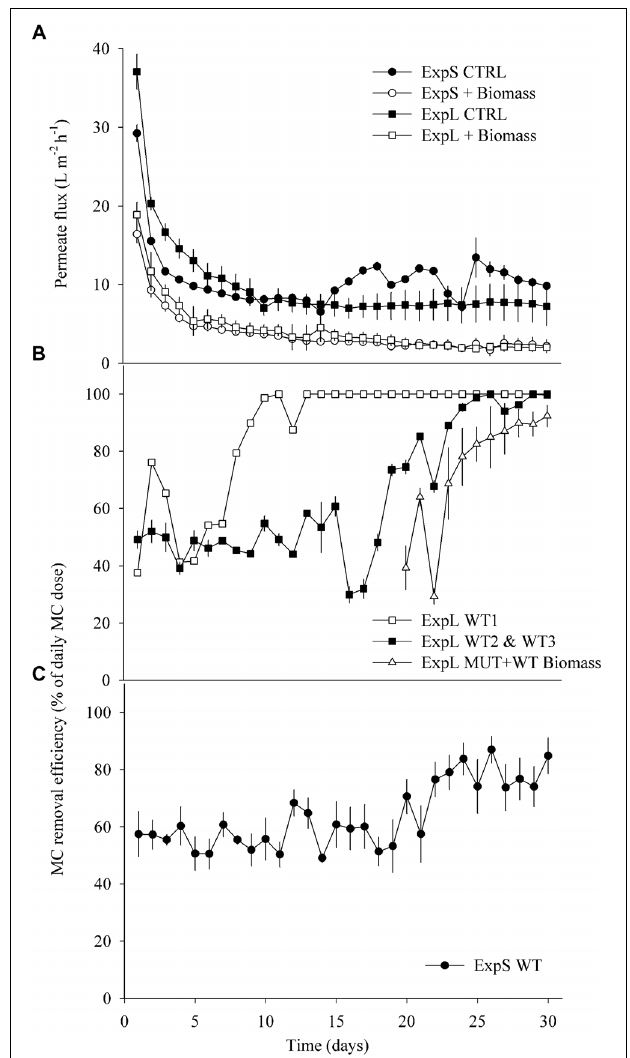
FIGURE 2 | (A) Average permeate flux in ExpL and ExpS. The label “ + Biomass” treatment refers to the average of the WT biomass and MUT (+WT biomass) treatments and the label “CTRL” to the treatments that received only lake or stream water. (B) Microcystin removal efficiency in ExpL. Note that the MUT+WT biomass treatment was supplemented with MC-free biomass until day 18 and with MC-containing biomass thereafter. WT 1, 2, and 3 refer to the three biological replicates of the WT treatment. (C) Microcystin removal efficiency in ExpS. Data are depicted as means ± one standard